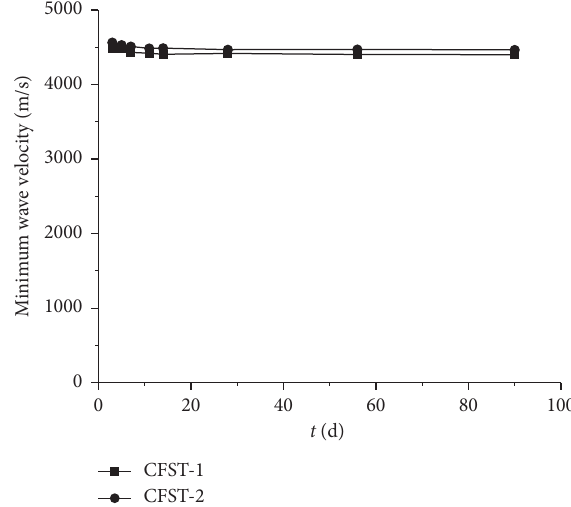
Figure 13: Velocity-time curve.